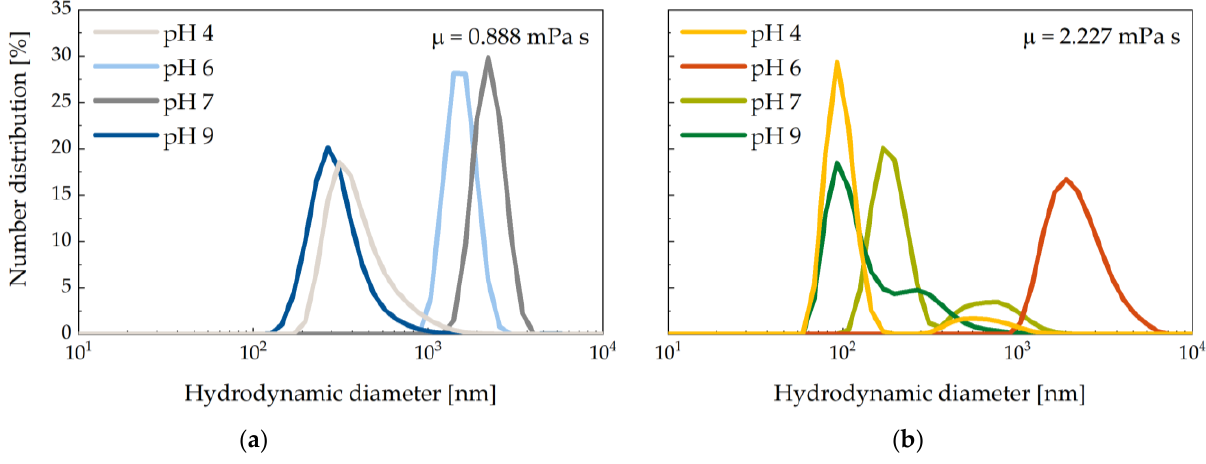
Figure 5. Particle size distribution at pH 4, 6, 7, and 9 of BION suspension ( a ) in deionized water (η = 0.888 mPa s) ( b ) and sucrose solution (η = 2.227 mPa s).